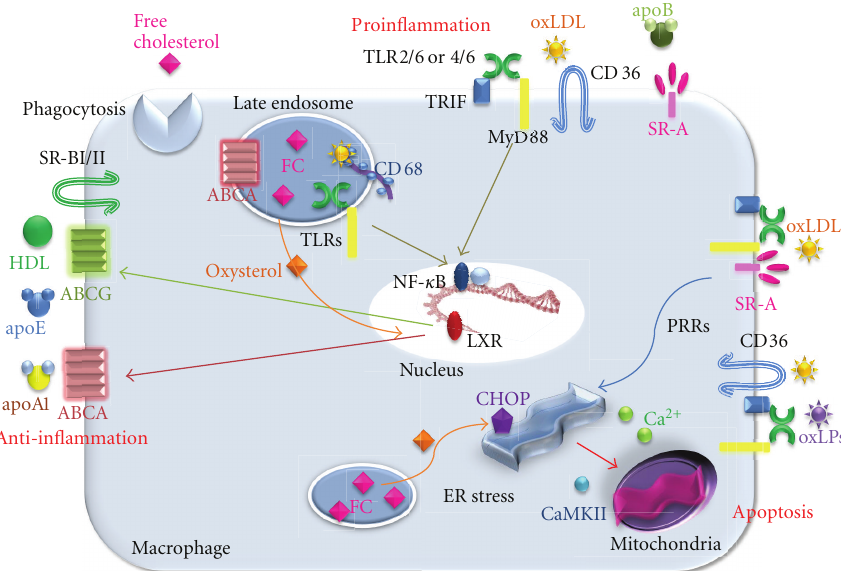
Figure 3: The fate of macrophages in an early lesion of atherosclerosis. The accumulation of apolipoprotein B-lipoproteins (apoB-LPs) in the matrix beneath the endothelial cell layer leads to the recruitment of monocytes. The cells di ff erentiating into macrophages undergo foam cell formation, leading to apoptosis. Because e ff erocytosis works e ffi ciently, this lesion does not develop necrotic core. The resolution of the inflammation results in decreased plaque